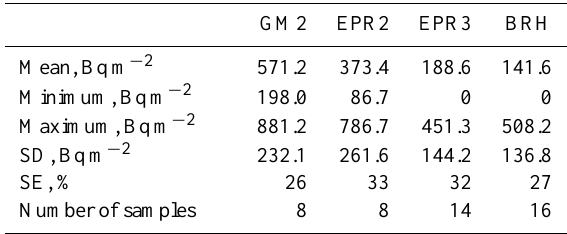
Table 2. The 1 37Cs inventories per soil profile for study